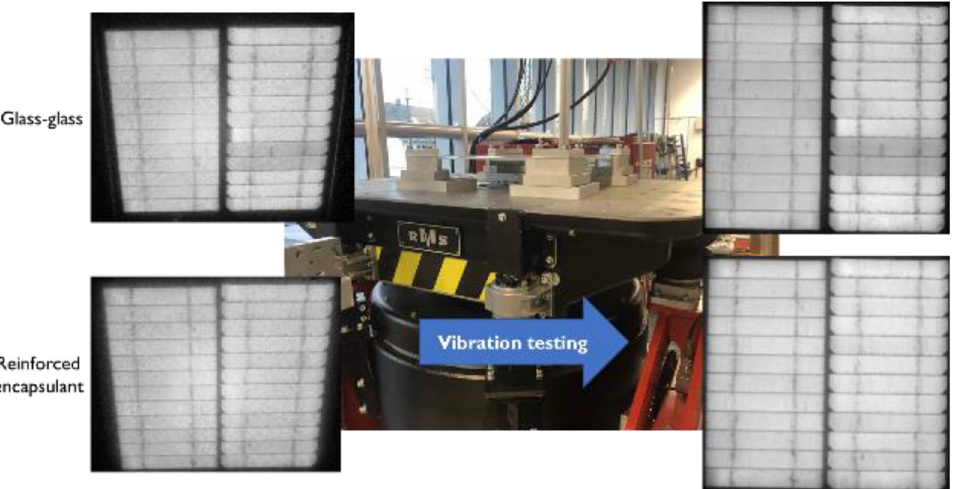
Fig. 5. EL images of a sample buildup with reinforced PO and a glass-glass reference before (left) and after (right) the random vibration testing carried out with a shaker (central image).